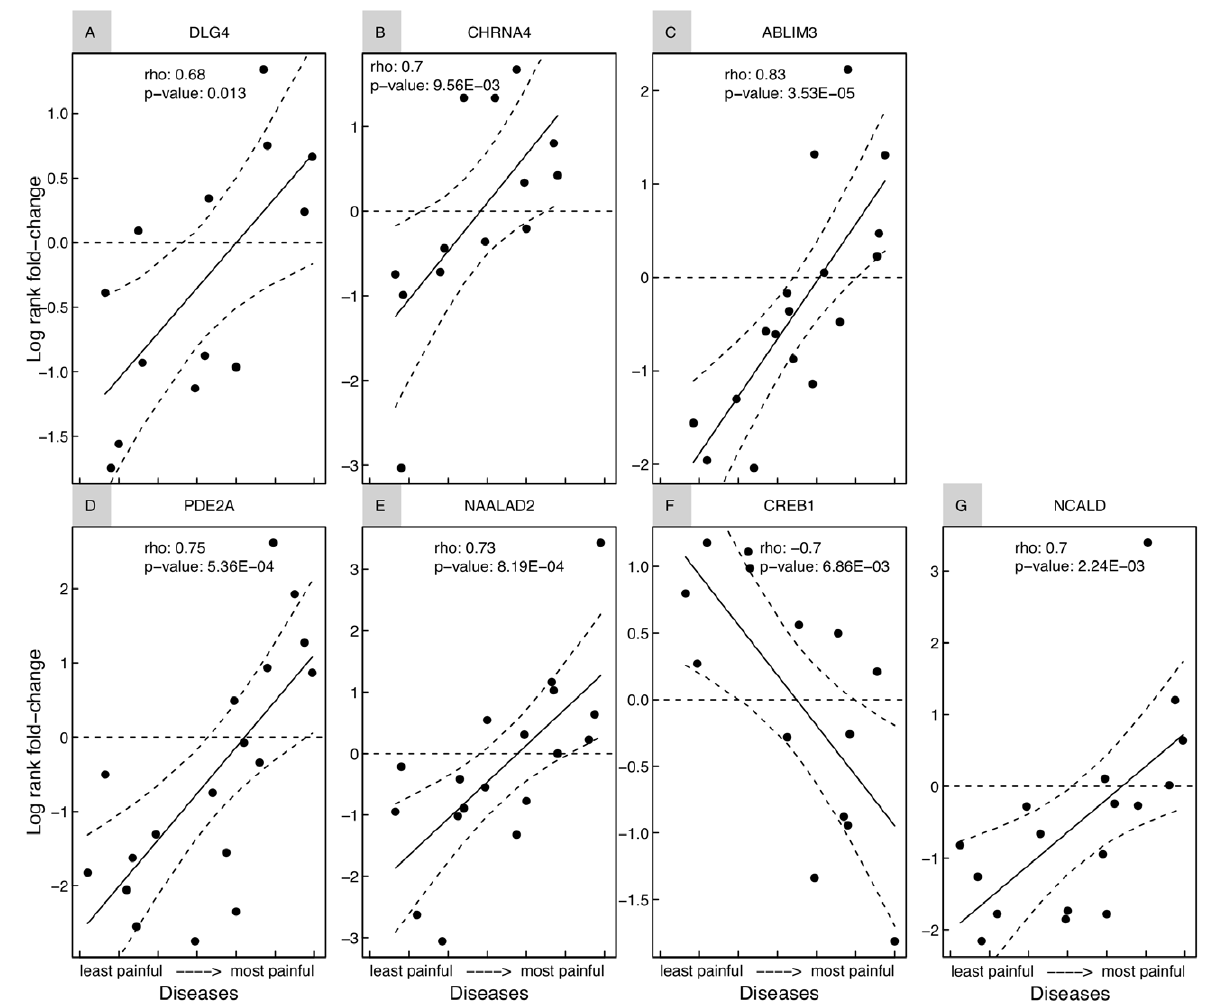
Figure 2. Genes with significant correlation between expression rank fold-change and disease-specific pain index (DSPI). (A, B) DLG4 and CHRNA4 are known pain genes listed in the Pain Gene Database. (C–G) ABLIM3 , PDE2A , NAALAD2 , CREB1 and NCALD were selected for further investigation through genotyping in an independent human cohort. X-axis represents disease ordered according to the DSPI. Y-axis displays the rank fold change. Solid line indicates linear regression fit. Rho Spearman correlation coefficient and uncorrected correlation p-values are shown. The curved dashed line represents the 95% confidence interval of the linear regression performed against the DSPI.